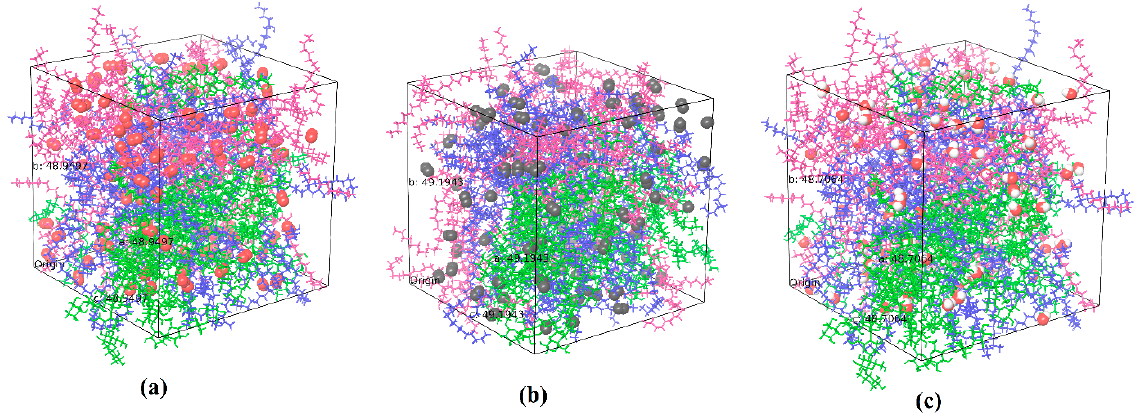
Figure 4. Equilibrated and relaxed adulose with ( a ) oxygen, ( b ) nitrogen, and ( c ) water molecules (red spheres are oxygen, grey spheres are nitrogen, red sphere with two white spheres are water molecules).